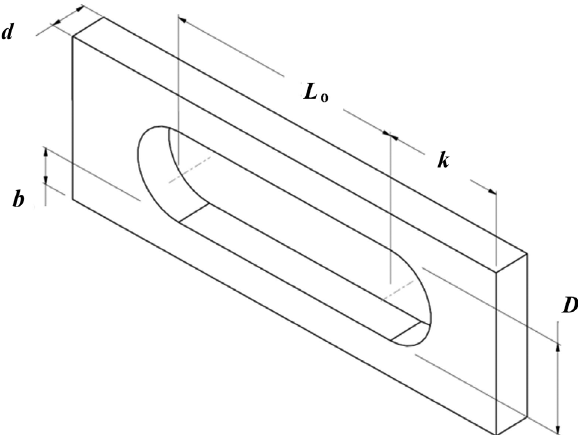
Figure 2: Photographs of scoop sampling in process on pipe work (a) and typical scoop sample (b).